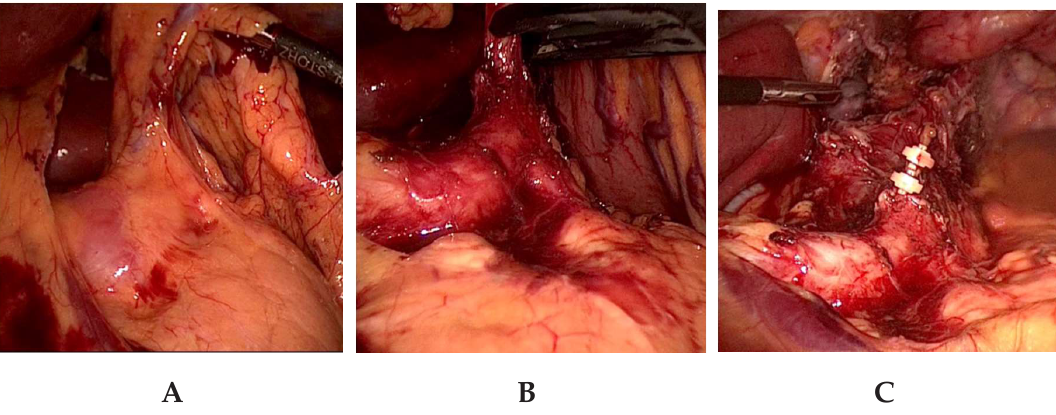
Figure 3. Abdominal and lower mediastinal lymphadenectomy. A . Anterior exposure. The axis of the left gastric artery is orientated upwards by the assistant. B . Lymphadenectomy at hepatic artery and celiac trunk. C . Situs after ligation of the left gastric artery, incision of the right pillar of the crus, lower mediastinal lymphadenectomy, and entry into the right pleural cavity.